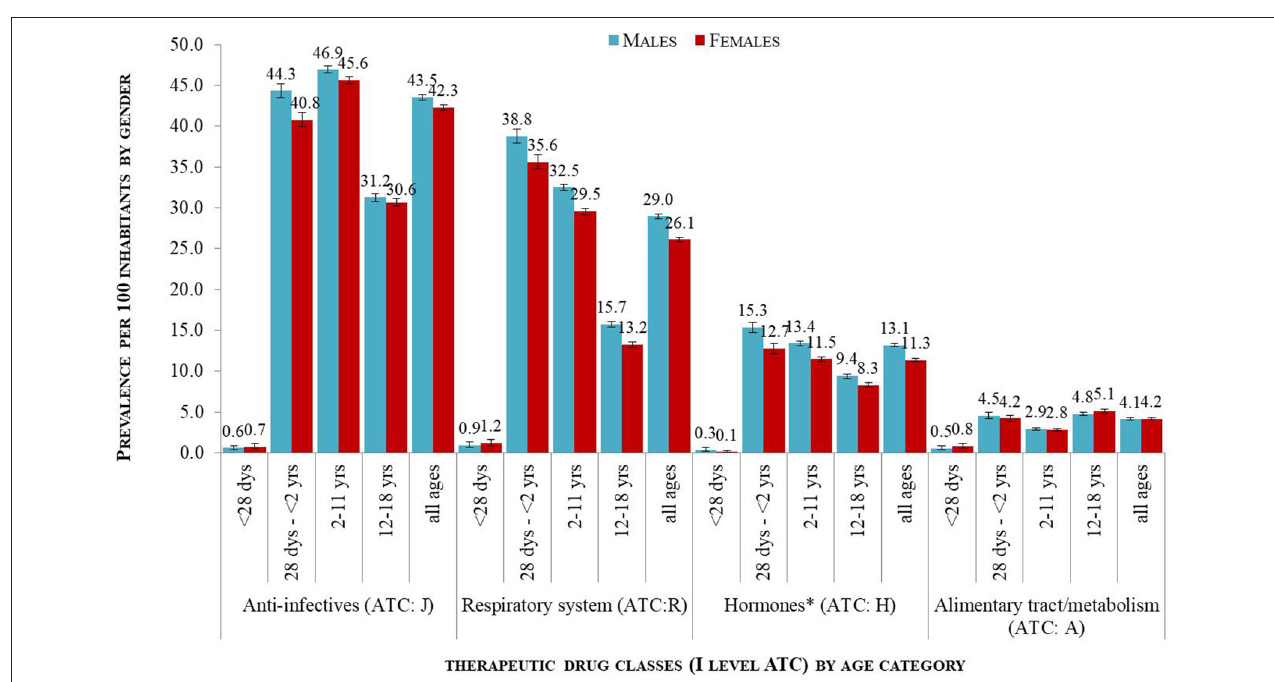
FIGURE 1 | Prevalence per 100 children distributed by age groups and gender by 1st level of ATC for the most commonly used drug classes in 2015. *Included systemic hormonal preparations and excluded sex hormones and insulins.